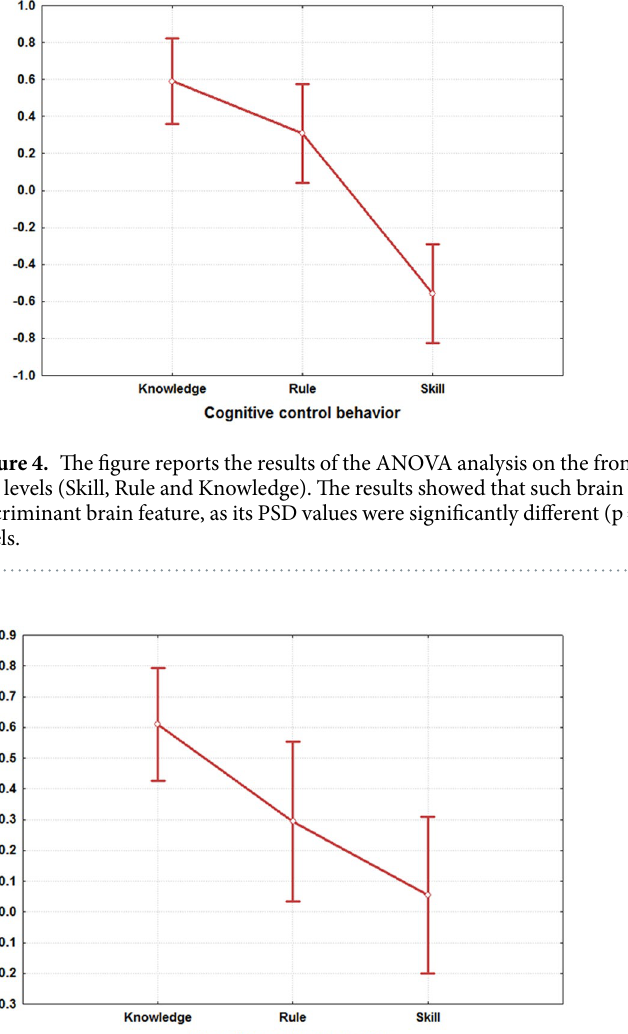
reports the Measured AUC (blue bars) from the Random AUC (orange bars) for each ATCO (Experts on the top part of the image) averaged across all the possible labels combinations. ATCO Experts.